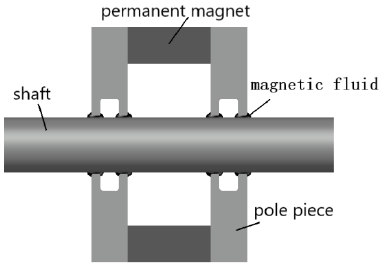
Figure 2. Schematic diagram of the magnetic fluid seal structure.